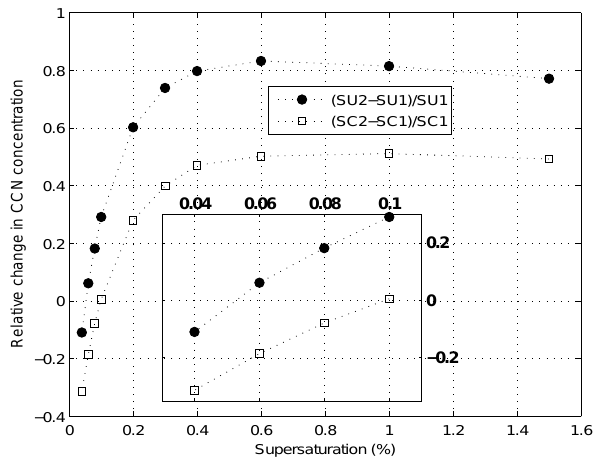
Fig. 6. Change in the cumulative CCN means for the late afternoon circles relative to the midday circles for the periods free of SO 2 precipitation and